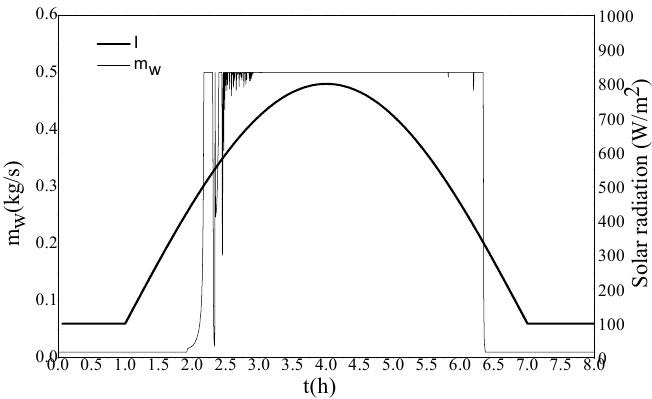
Figure 10. Variations in solar radiation and the rate of flow of water in the water solar collector.